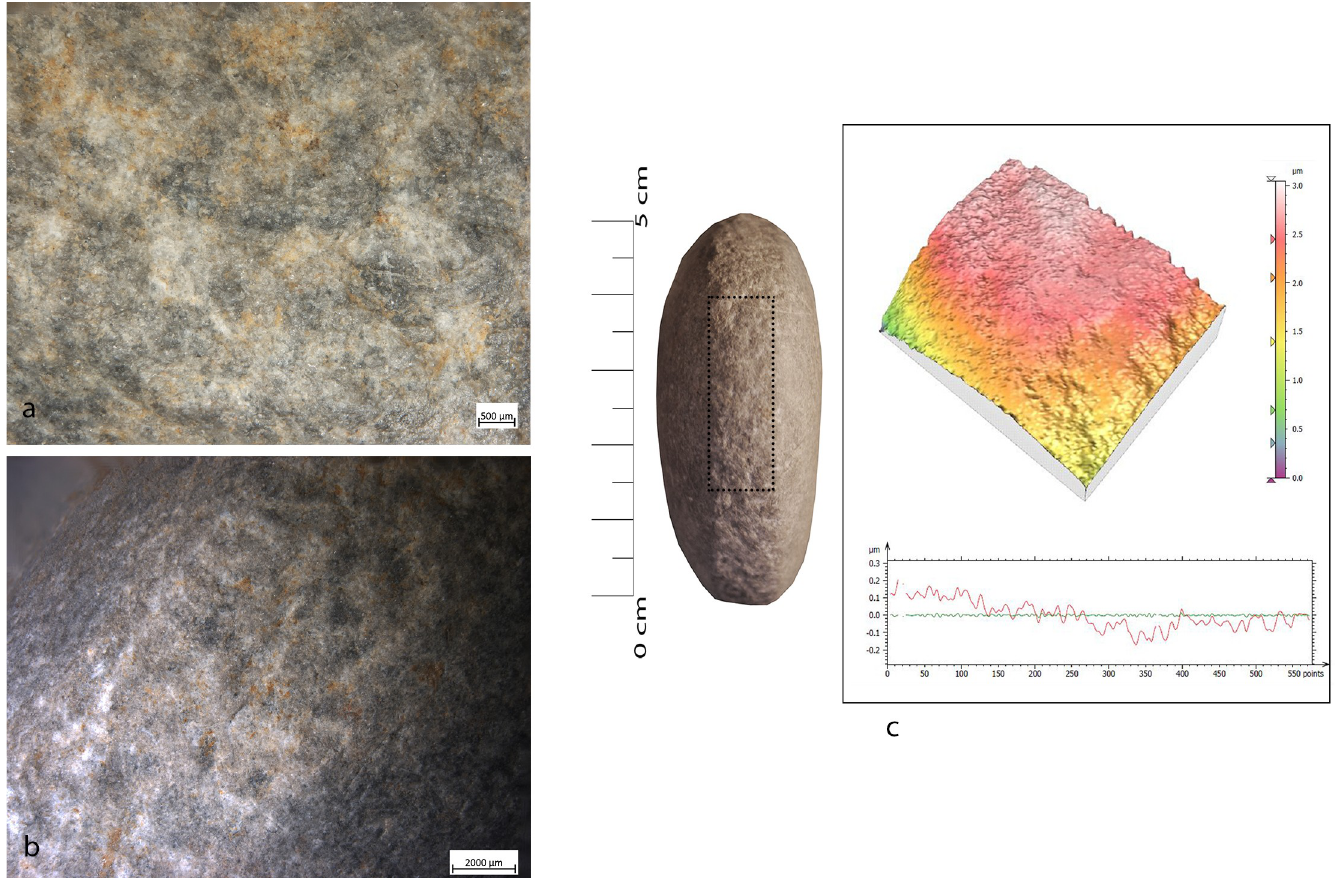
Fig 19. Use wear identified on artefact RF127. (a) Macro-traces (25x), overlaid pits with sub-circular morphology; (b) macro-traces (10x), pits located around the short edge of the artefact; (c) 3D microtopography of the used surface and profile.